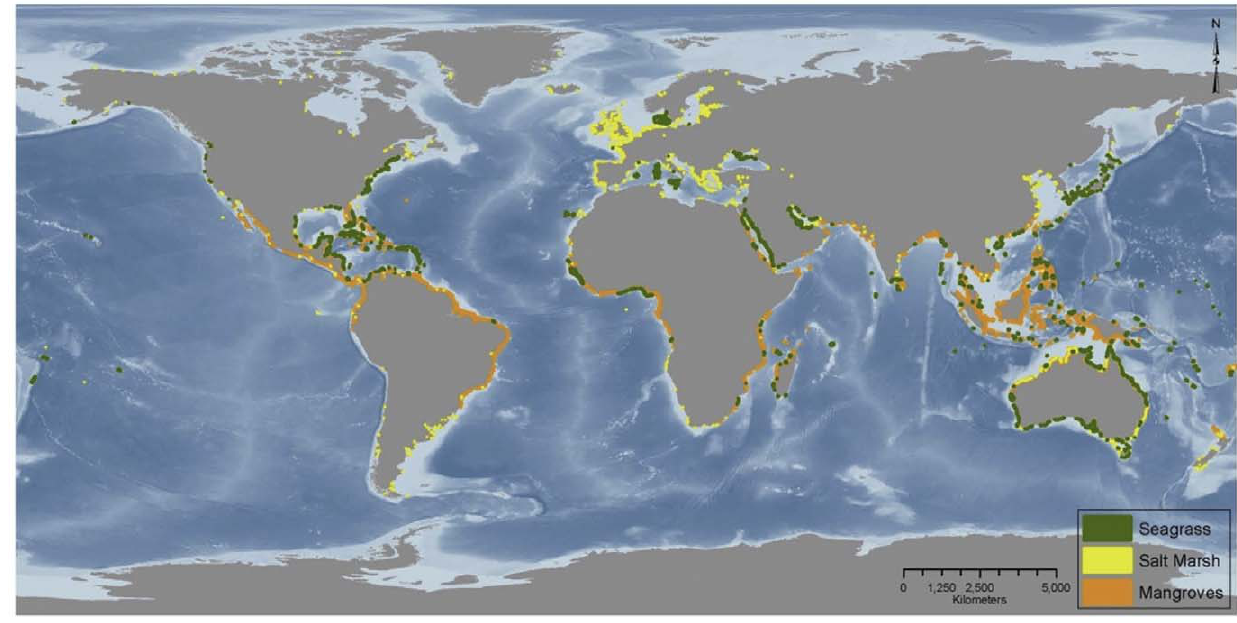
Figure 1. Global distribution of seagrasses, tidal marshes, and mangroves. Data sources: Seagrass and saltmarsh coverage data are from the United Nations Environment Programme World Conservation Monitoring Centre (UNEP-WCMC); mangrove coverage data are from UNEP-WCMC in collaboration with the International Society for Mangrove Ecosystems (ISME).